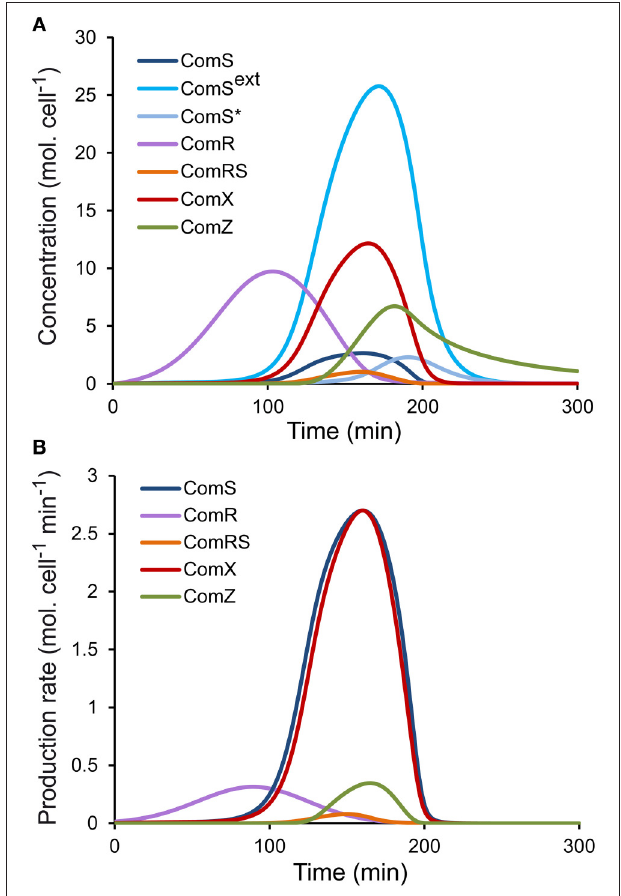
FIGURE 2 | Simulated profiles of molecular species of the ComRS model. Time-course evolution of (A) the concentrations (molecules (mol.) cell − 1 ) and (B) the production rates [molecules (mol.) cell − 1 min − 1 ] of the modeled molecular species in a WT LMD-9 strain in CDML growth conditions.